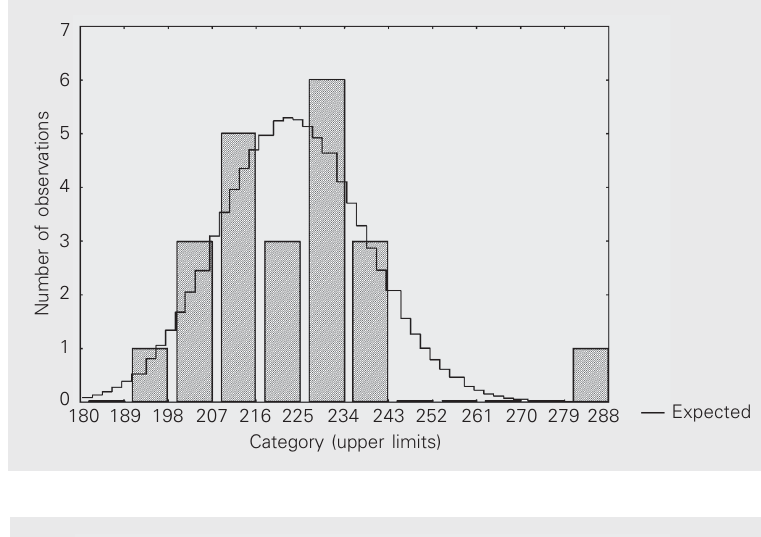
Figure 4. Distribution of radiosensitivity among indi- viduals aged on average 36.8 years (Kolmogorov- Smirnof test, d = 0.36, P <